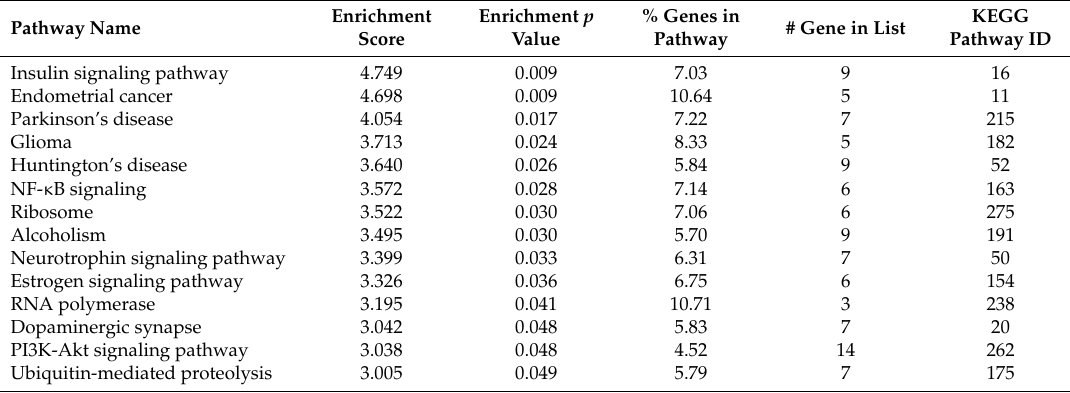
Table 6. Functional enrichment of Kyoto Encyclopedia of Genes and Genomes (KEGG) pathway analysis in the identified CNAs (>100 kb and occurring in two or more patients with SCC).